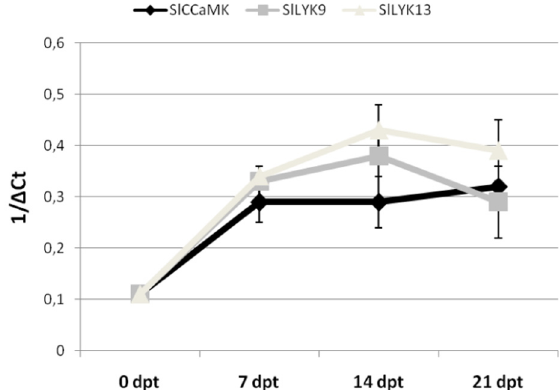
Figure 5. Expression of SlCCaMK , SlLYK9 , and SlLYK13 genes in tomato roots after treatment of plants with Myco2. Expression of genes was detected by quantitative real-time reverse-transcription polymerase chain reaction (qRT-PCR) in roots of tomato plants at 0, 7, 14, and 21 days post-treatment (dpt). Gene transcript levels are expressed as 1/ ∆ C t , where ∆ C t is the difference between the cycle thresholds of fluorescence signal of the tested gene and the signal of the reference gene ( Actin 2 ). Data are mean ( n = 6) ± SD.